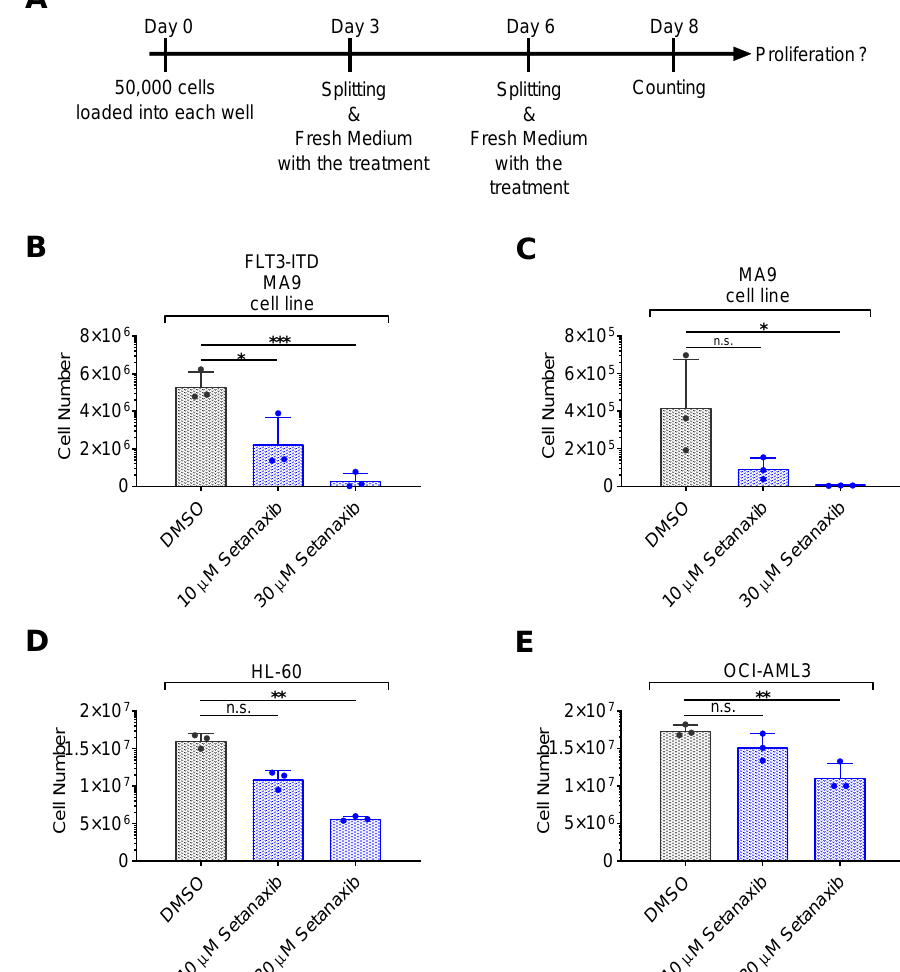
Figure 1. Setanaxib inhibits the proliferation of AML cell lines. The effect of Setanaxib on the proliferation of different leukemic cells was assessed. Experimental conditions for treatment with Setanaxib were as indicated in ( A ), and results are shown in ( B – E ).